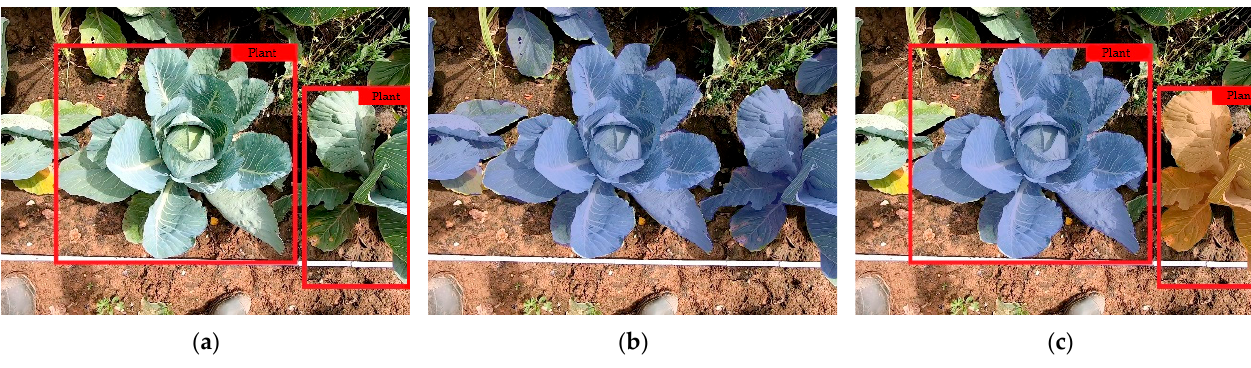
Figure 2 . Example for an RGB image with a corresponding depth image (colored) . Figure 2. Example for an RGB image with a corresponding depth image (colored).